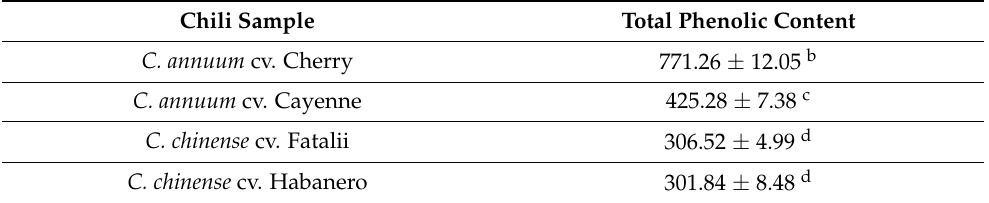
Table 3. Variation of total phenolic compounds in the samples of fermented freeze-dried chili